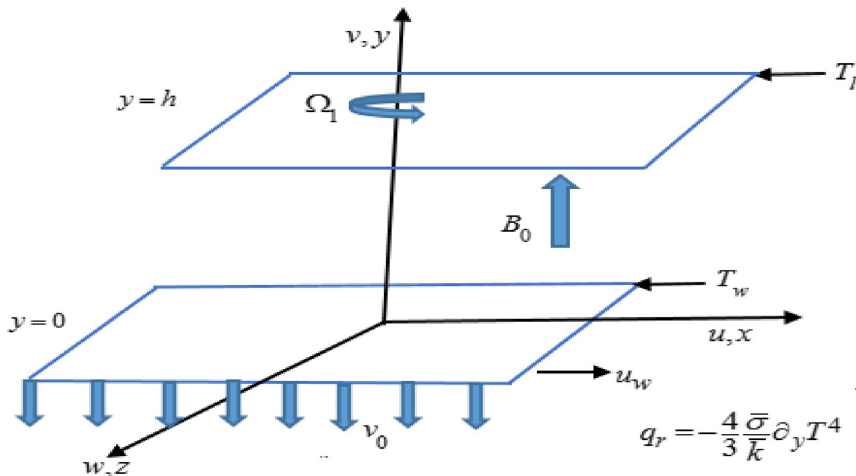
Figure 1. Schematic illustration of the